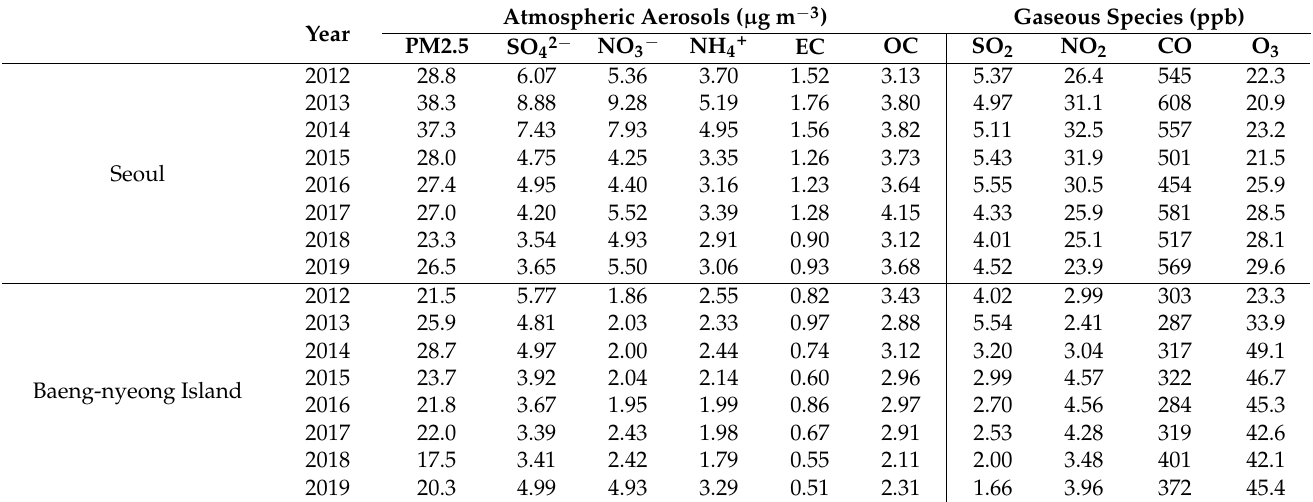
Table 1. The annual mean concentrations of major air pollutants between 2012 and